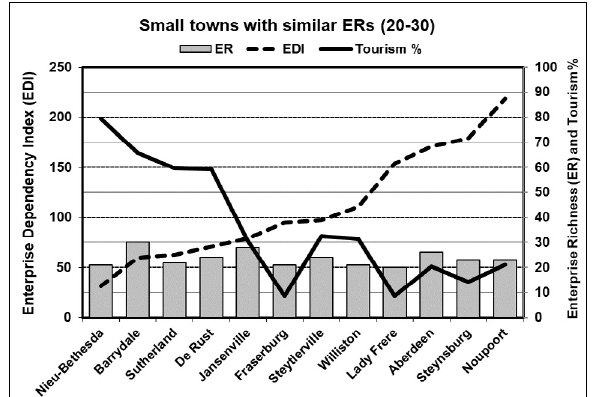
The share of the tourism and hospitality sector of the total enterprises (tourism%) and the wealth/poverty states (EDI) of towns with enterprise richness (ER) values between 20 and 30.